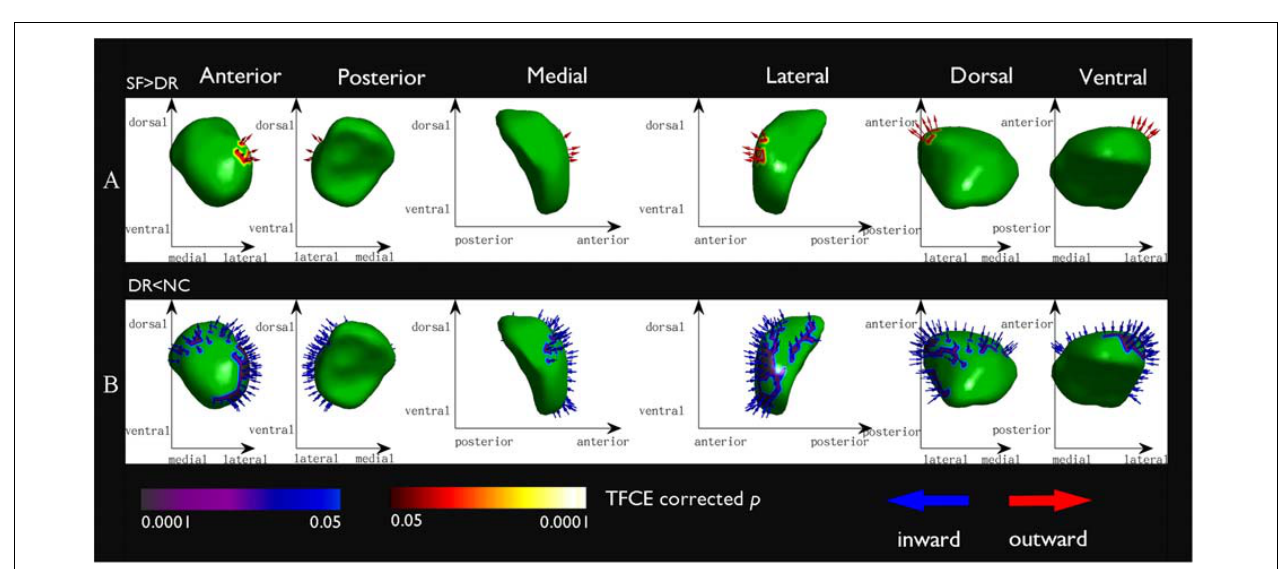
FIGURE 3 | (A) Volume distribution of the left amygdala in patients and healthy controls. (B) Intragroup volume of the bilateral amygdala. SF, seizure free; DR, drug resistant; NC, normal control. The results were corrected for sex, age, and ICV ( p < 0.05).